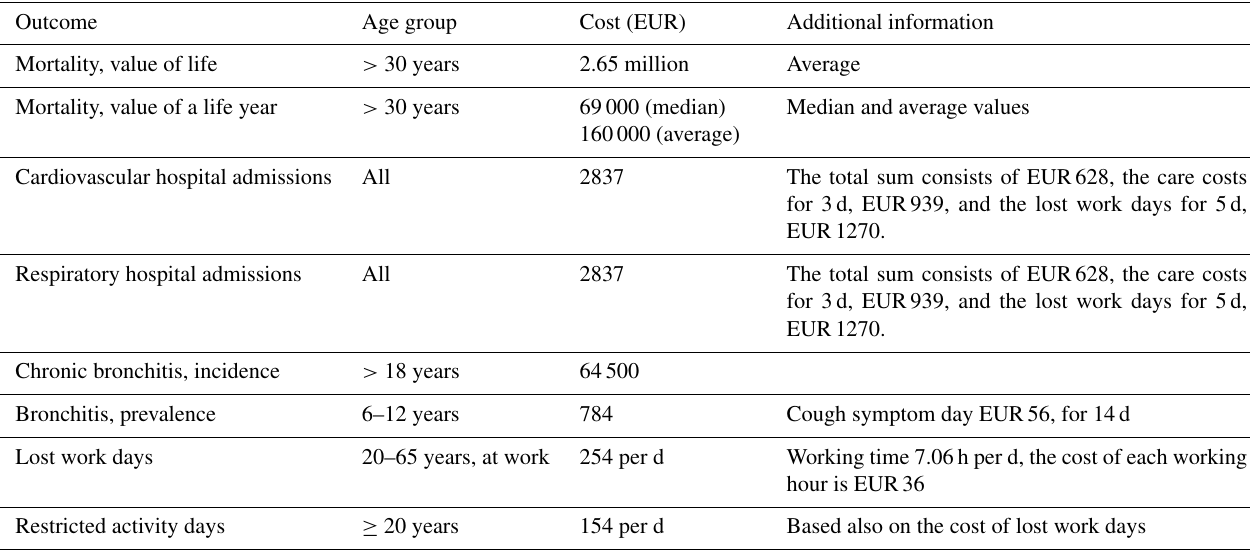
Table 2. The unit costs (in EUR) of the health outcomes that were included in the model. All values are mainly based on the willingness-to- pay